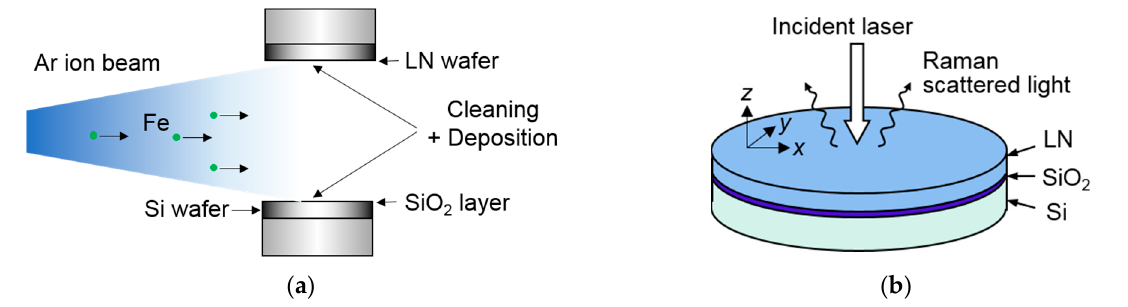
Figure 1. ( a ) Schematic diagram of modified surface activation process. ( b ) Schematic illustration of measurement of stress in bonded lithium niobate (LN) film layer.